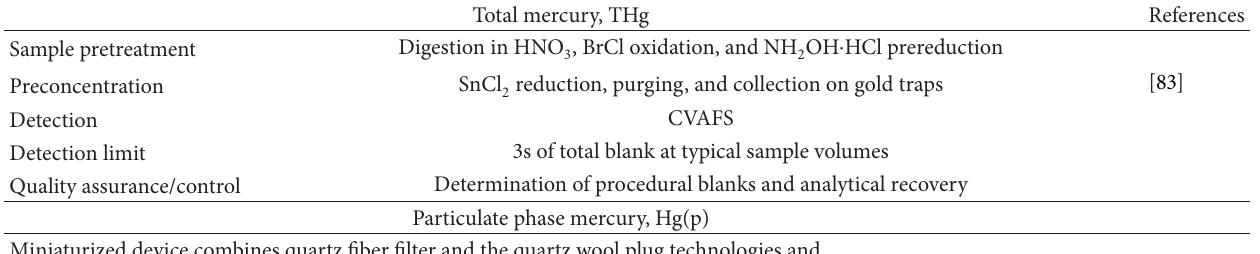
Table 5: Analysis of total mercury and particulate phase